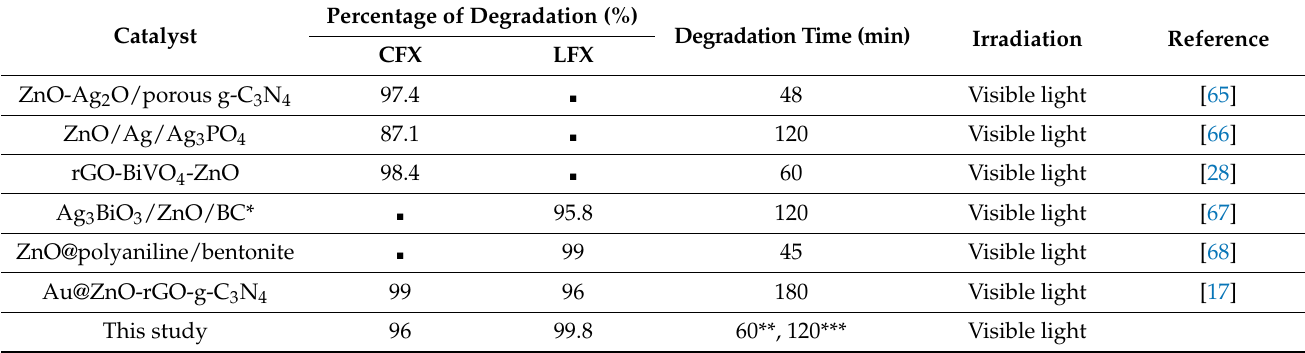
Table 1. Comparison of the degradation of CFX and LFX using different ZnO heterostructured